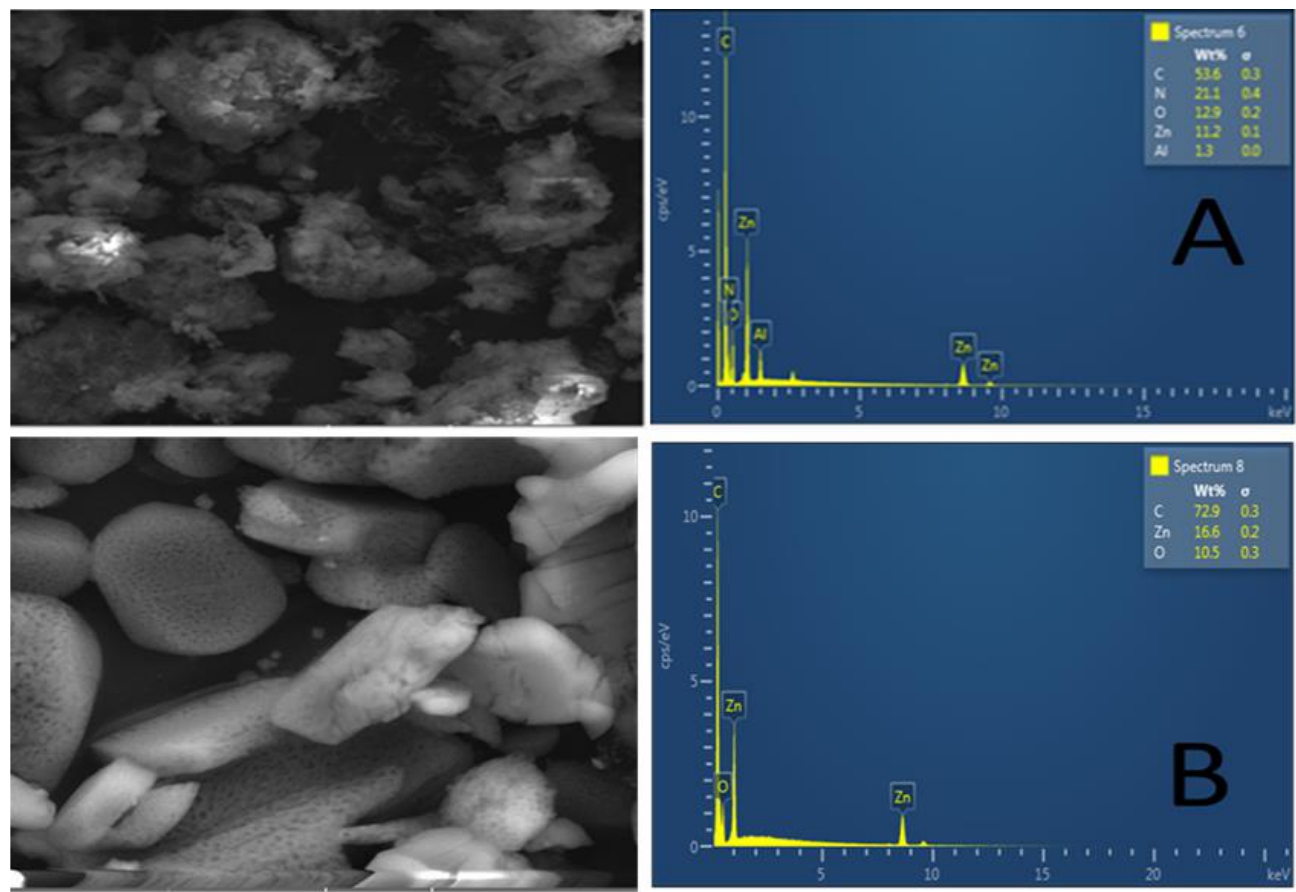
Figure 3. SEM and EDX images of ( A ) Zn−Al−LDH@ZIF−8 nanocomposite and ( B )